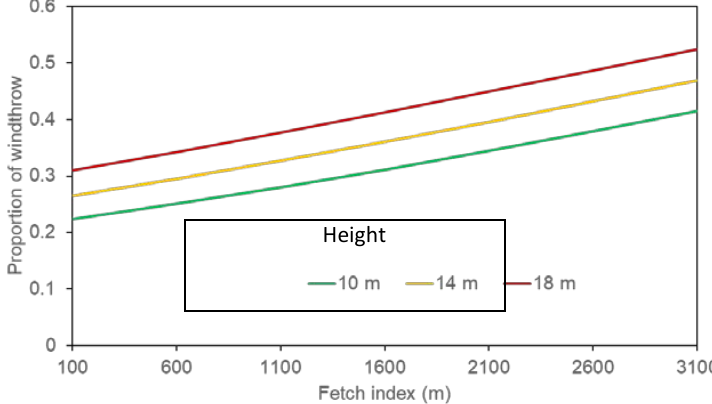
Figure 3. Effect of the fetch index and tree height on the predicted amount of windthrow, considering only cases where windthrow is present. The graph is for an edge stand made of 60% balsam fir, 55 years old, and with a stand density of 2000 stems/ha. Derived from equations of Larouche [30]. Both types of spatial clearcutting patterns differ, not only in terms of clearcut size, but also in terms of the use of buffer strips. In order to compare both strategies, it is necessary to compare them on a common basis. The amount of damage per unit of edge length was quite similar for both types